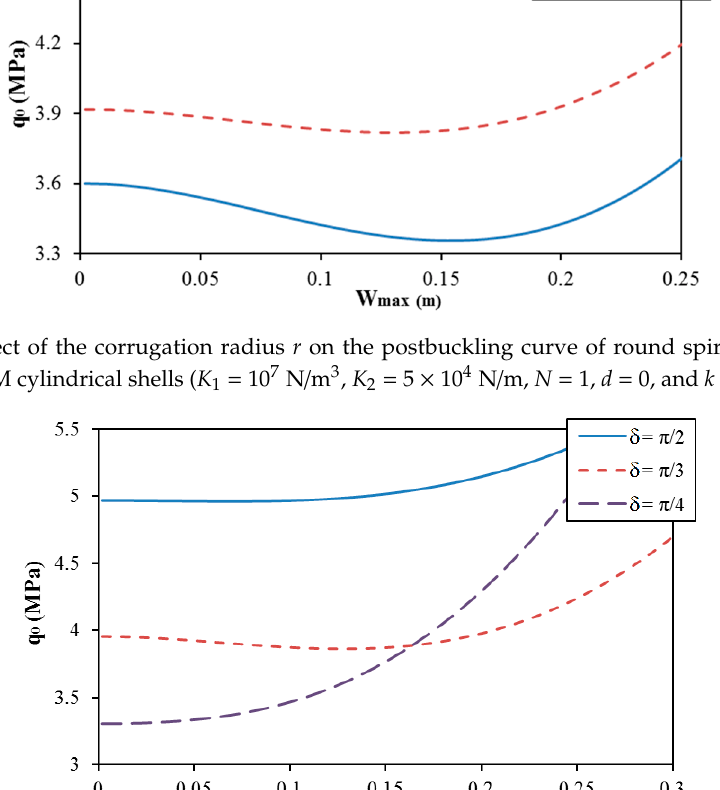
Figure 5. E ff ect of the angle δ of corrugation on the postbuckling curve of trapezoidal spiral corrugated sandwich FGM cylindrical shells ( K 1 = 10 7 N / m 3 , K 2 = 5 × 10 4 N / m, N = 1; e = 0.03 m, and k =